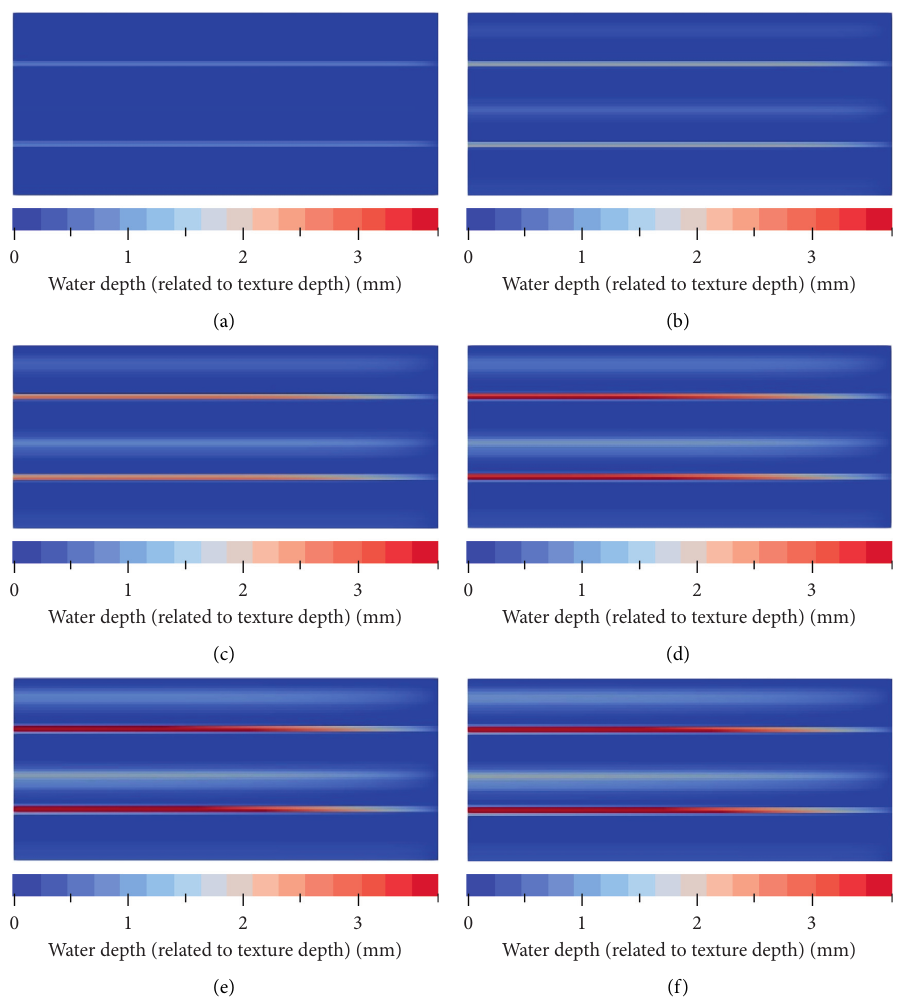
Figure 10: Example 3: evolution of water depths in (and outside of) the ruts after the beginning of a heavy rainfall (rut depth and geometry after 30 years). (a) t � 10s. (b) t � 30s. (c) t � 45s. (d) t � 60s. (e) t � 80s. (f) t � 900s